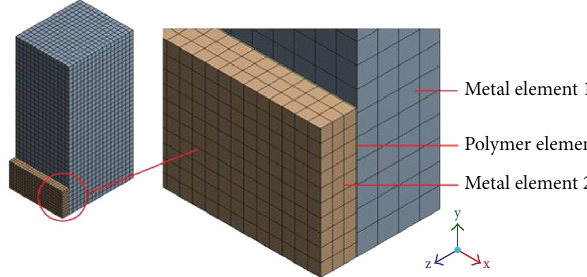
Figure 6: 3D model of the sample with a bonded cuboid